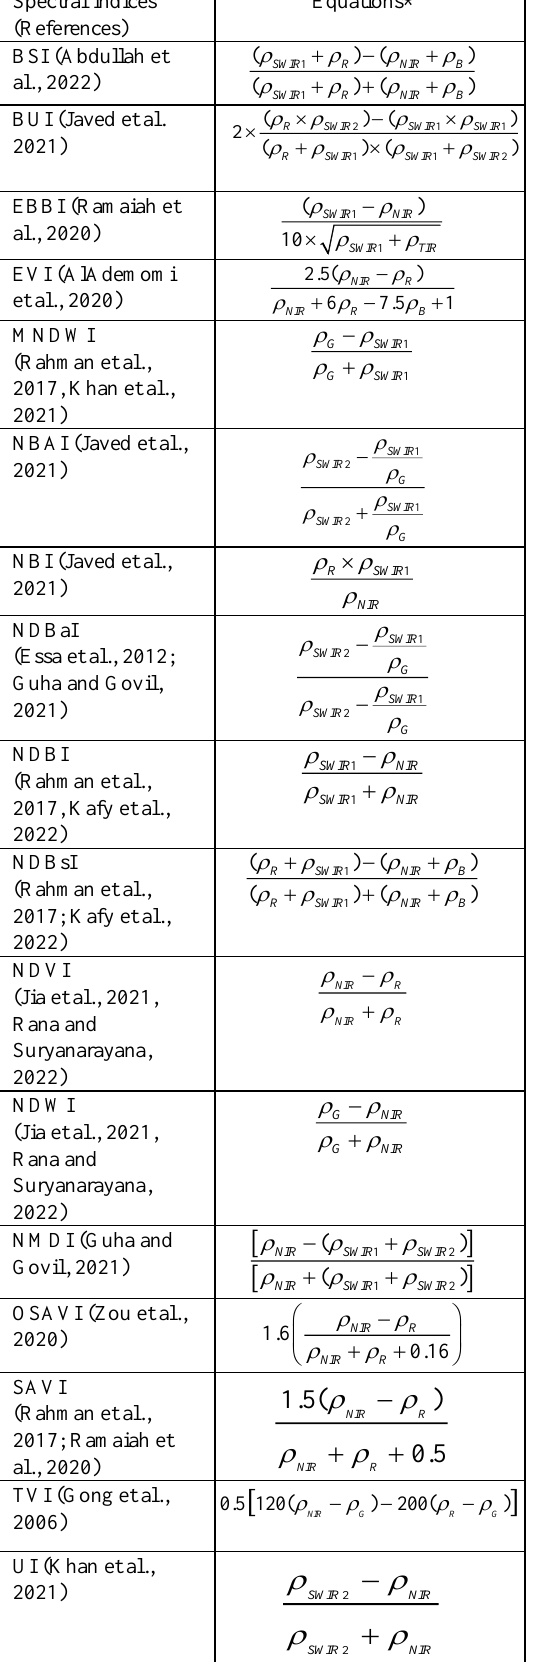
Table 1 . Spectral indices of the surface parameters *